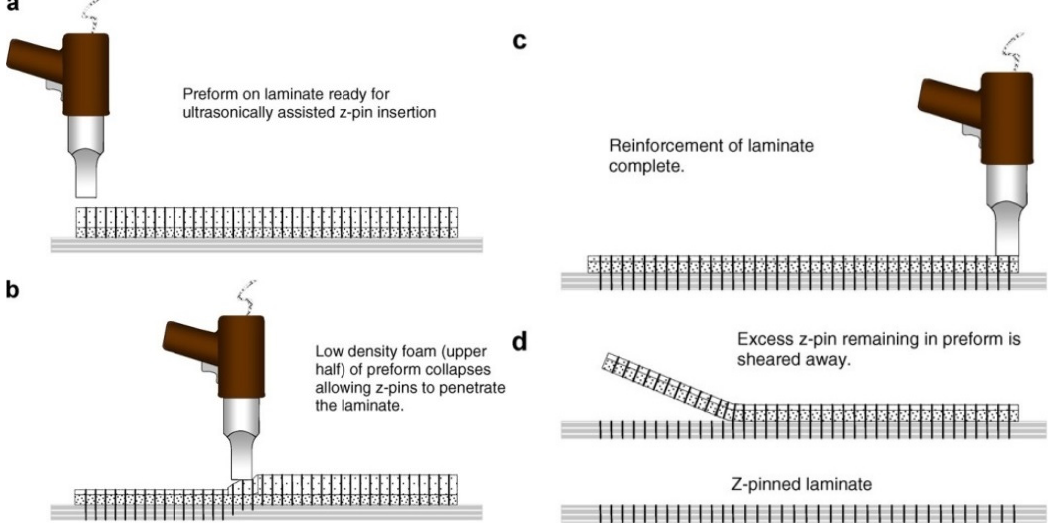
F igure 2. Schematic of the UAZ® process [11]. Figure 2. Schematic of the UAZ ® process